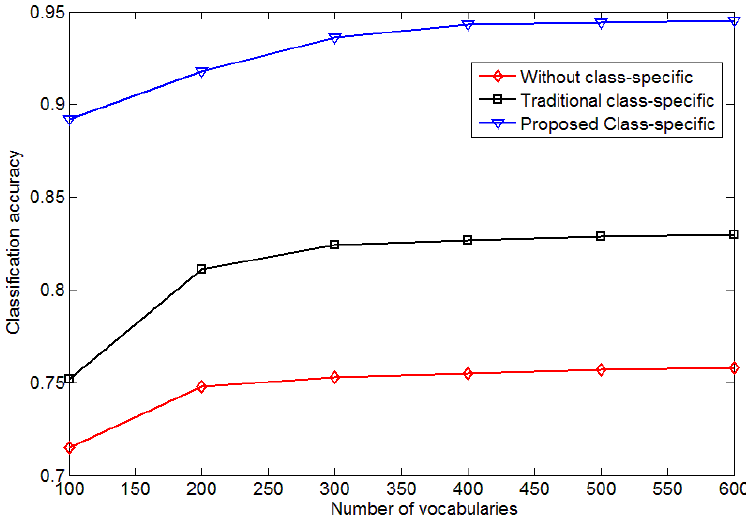
Figure 22. Classification accuracy with a different number of visual words in UC_MERCED land-use dataset.